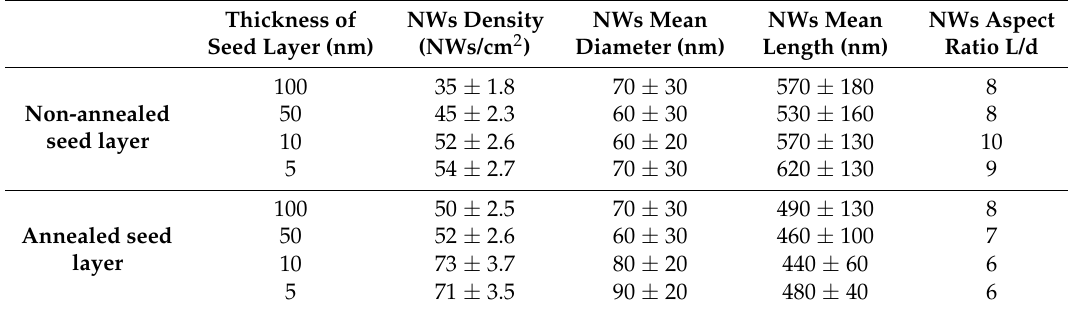
Table 2. ZnO NW morphology depending on the thickness and heat treatment of the ZnO seed layer.